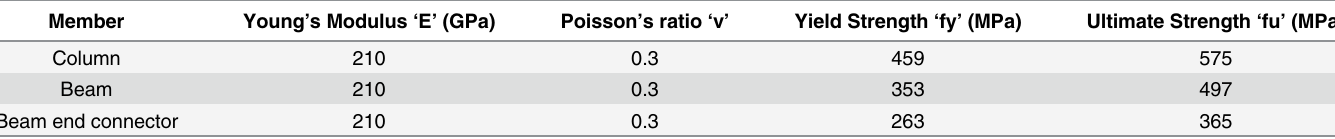
Table 1. Material properties of specimens.